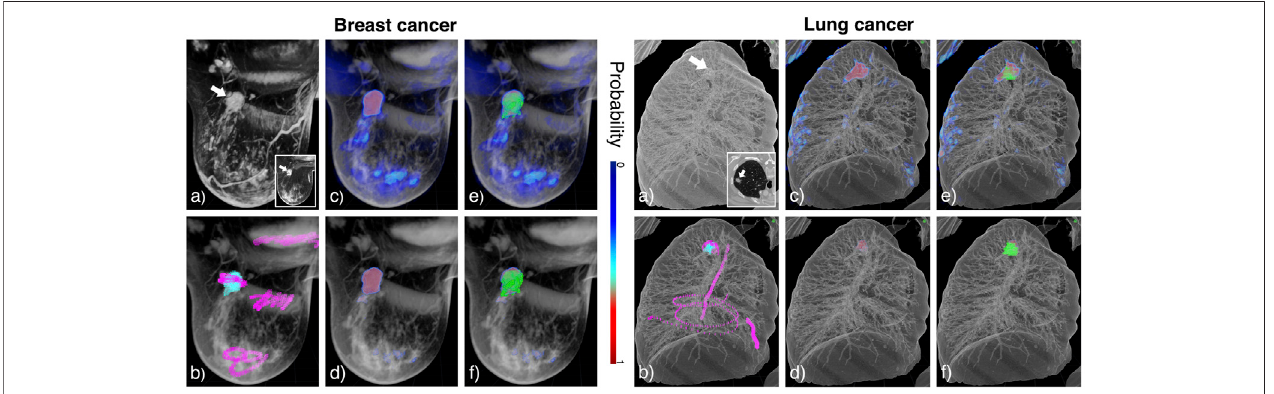
FIGURE6| AnnotationinDIVAonthebreastMRI(left panel) andthelungCT-scan (rightpanel) andtumor (whitearrow). (A) Rawdatavisualizedin3DonDIVAand as an image stack in the bottom right corner. (B) Overlay of theraw image in gray and tags withpositiveand negative tags in cyan and magenta,respectively. Tagging is performed in VR to quickly annotate which voxels belong to the structure of interest and which do not. (C,D) Overlay of the raw image in gray and output probabilities, respectively for the RFC and the strong learner. (E,F) Overlay of the raw image in gray, output probabilities, and ground truth segmentation in green for RFC and strong learner, respectively. Colorscale for probabilities is indicated between the two panels.